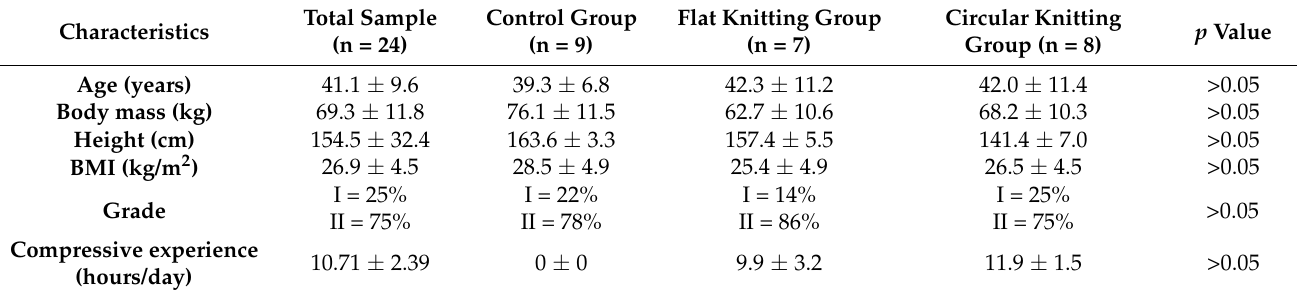
Table 1. Sociodemographic characteristics of the sample.